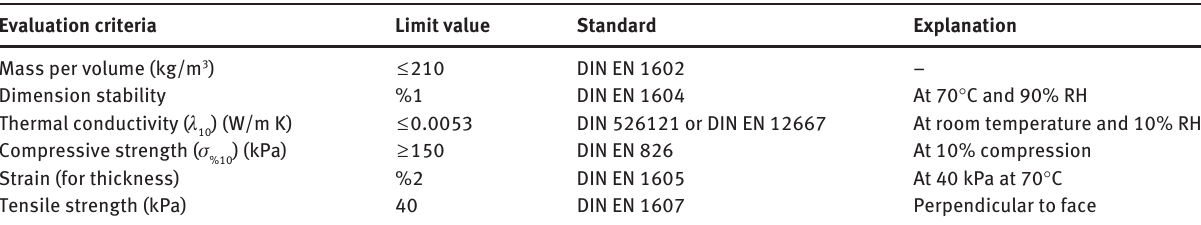
Table 2 Evaluation criteria of VIP properties